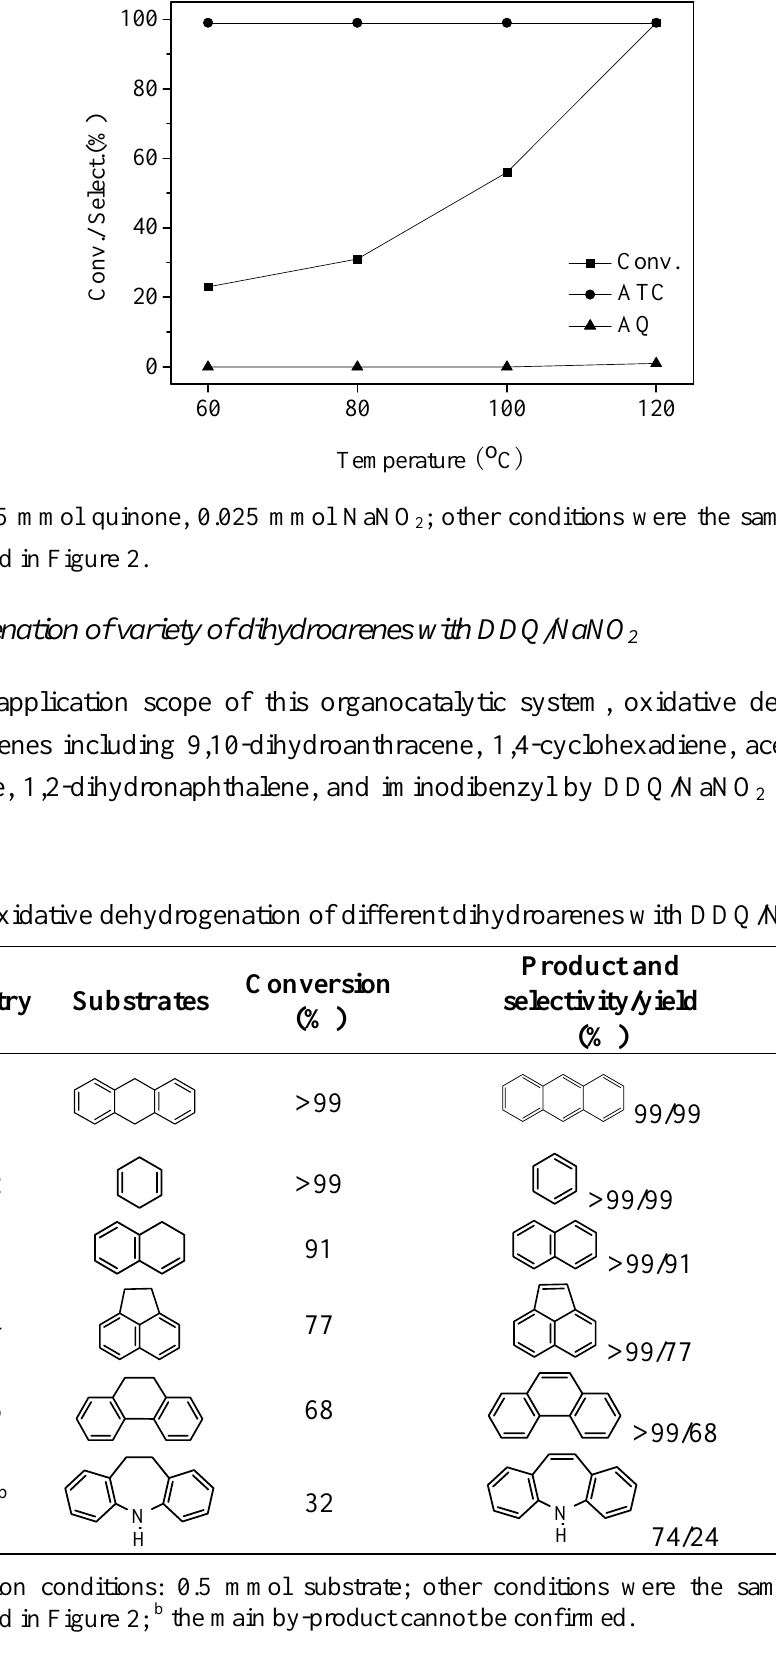
120020406080100 % ) . ( ec t e l S / onv . Conv. ATC C AQ 60 80 100 o Temperature ( C )